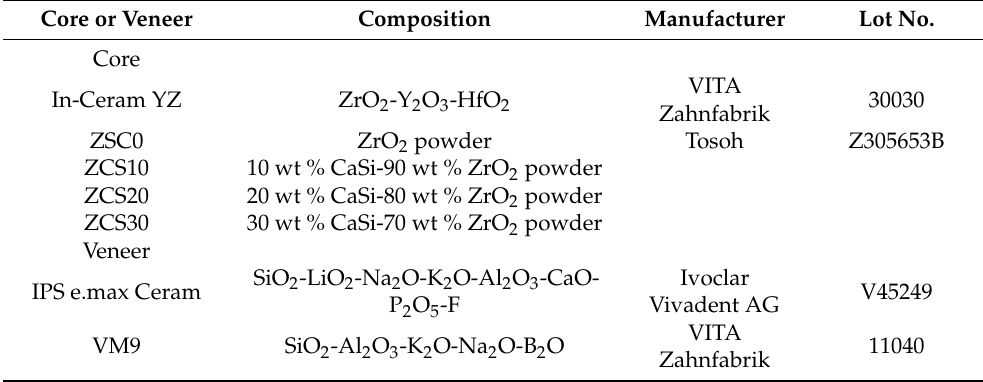
Table 1. Core and veneering ceramics used in